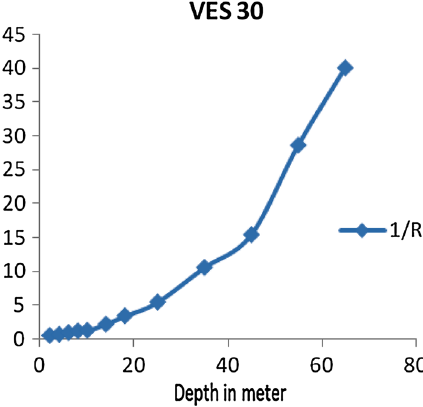
Fig. 6 Representative resistivity curve obtained by the inverse slope method from Shirpur taluka